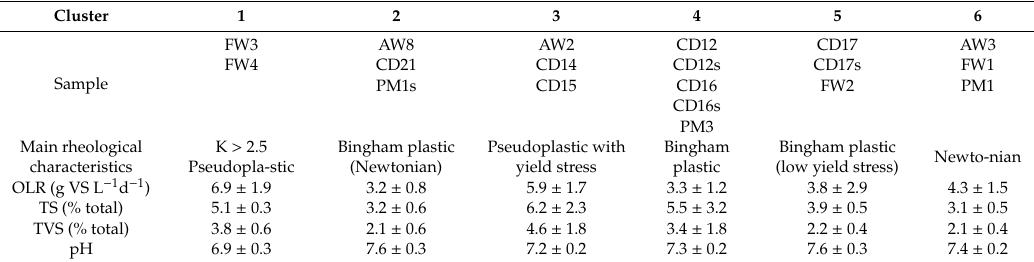
Table 2. K-means clustering results. Reactor names are composed of the two-letter substrate designation and a specific numeral. Lowercase “s” stands for the second sampling from the same reactor.